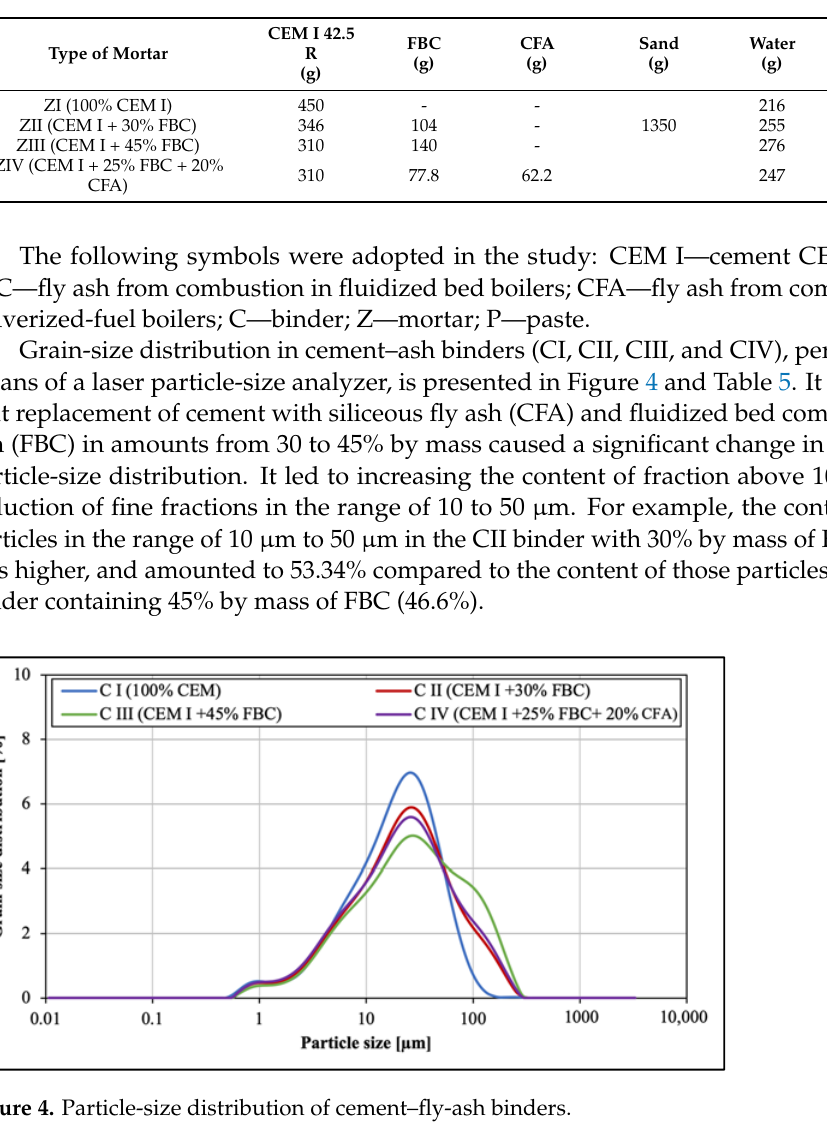
Table 4. Composition of mortars tested.